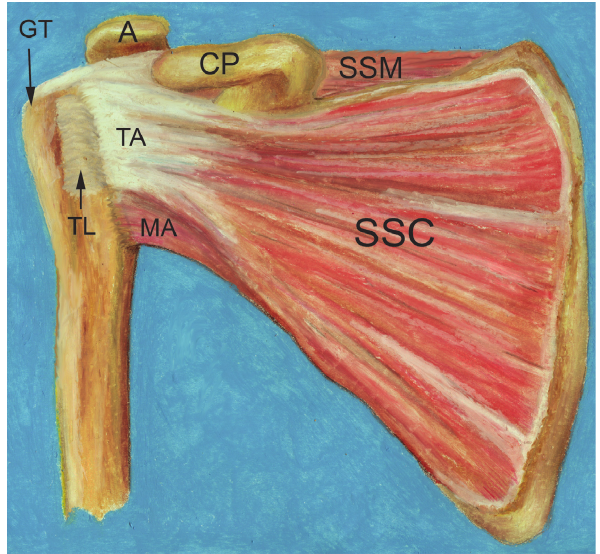
Figure 1: Anatomy of the subscapularis muscle. The subscapularis muscle (SSC) with its tendinous attachment (TA) and muscular attachment (MA) at the humerus. The transverse ligament (TL) covers the bicipital groove. The supraspinatus muscle (SSM) and tendon insert onto the greater tuberosity (GT). The acromion (A) and coracoid process (CP) are depicted (illustration courtesy of Virginia Diaz).